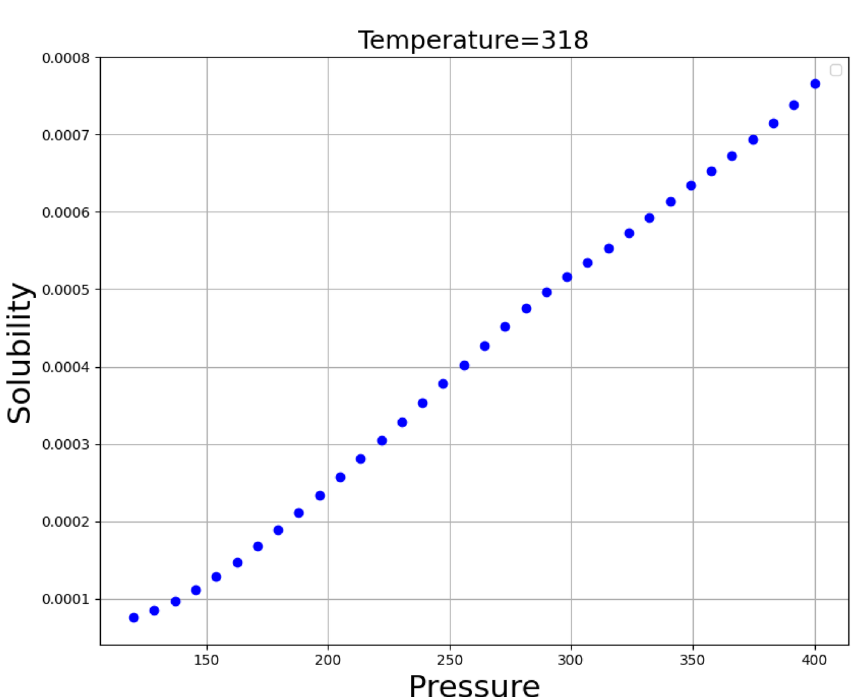
Figure 4. Trends for